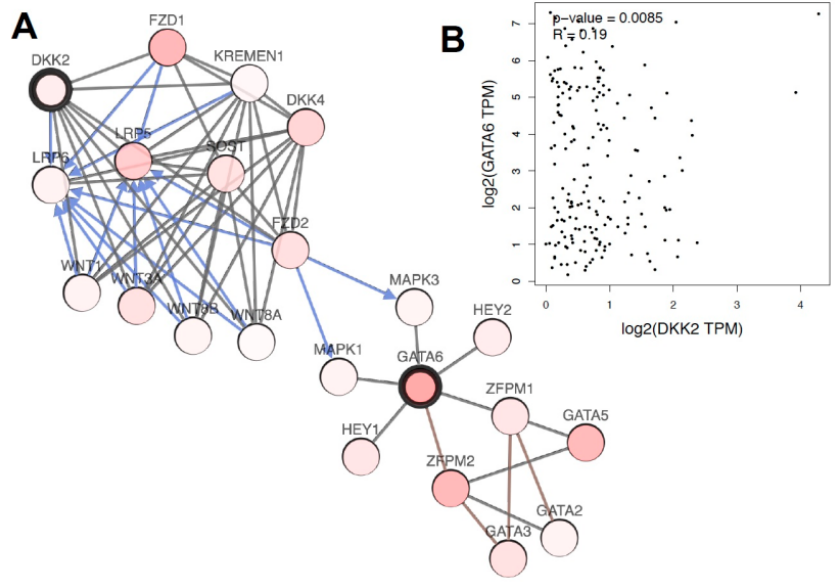
Figure 5. Visualization of the connection of DKK2 and GATA6 on gene level based on TCGA data, analyzed by cBioportal ( A ). Correlation of gene amplification between DKK2 and GATA6 in esophageal adenocarcinoma ( B ).